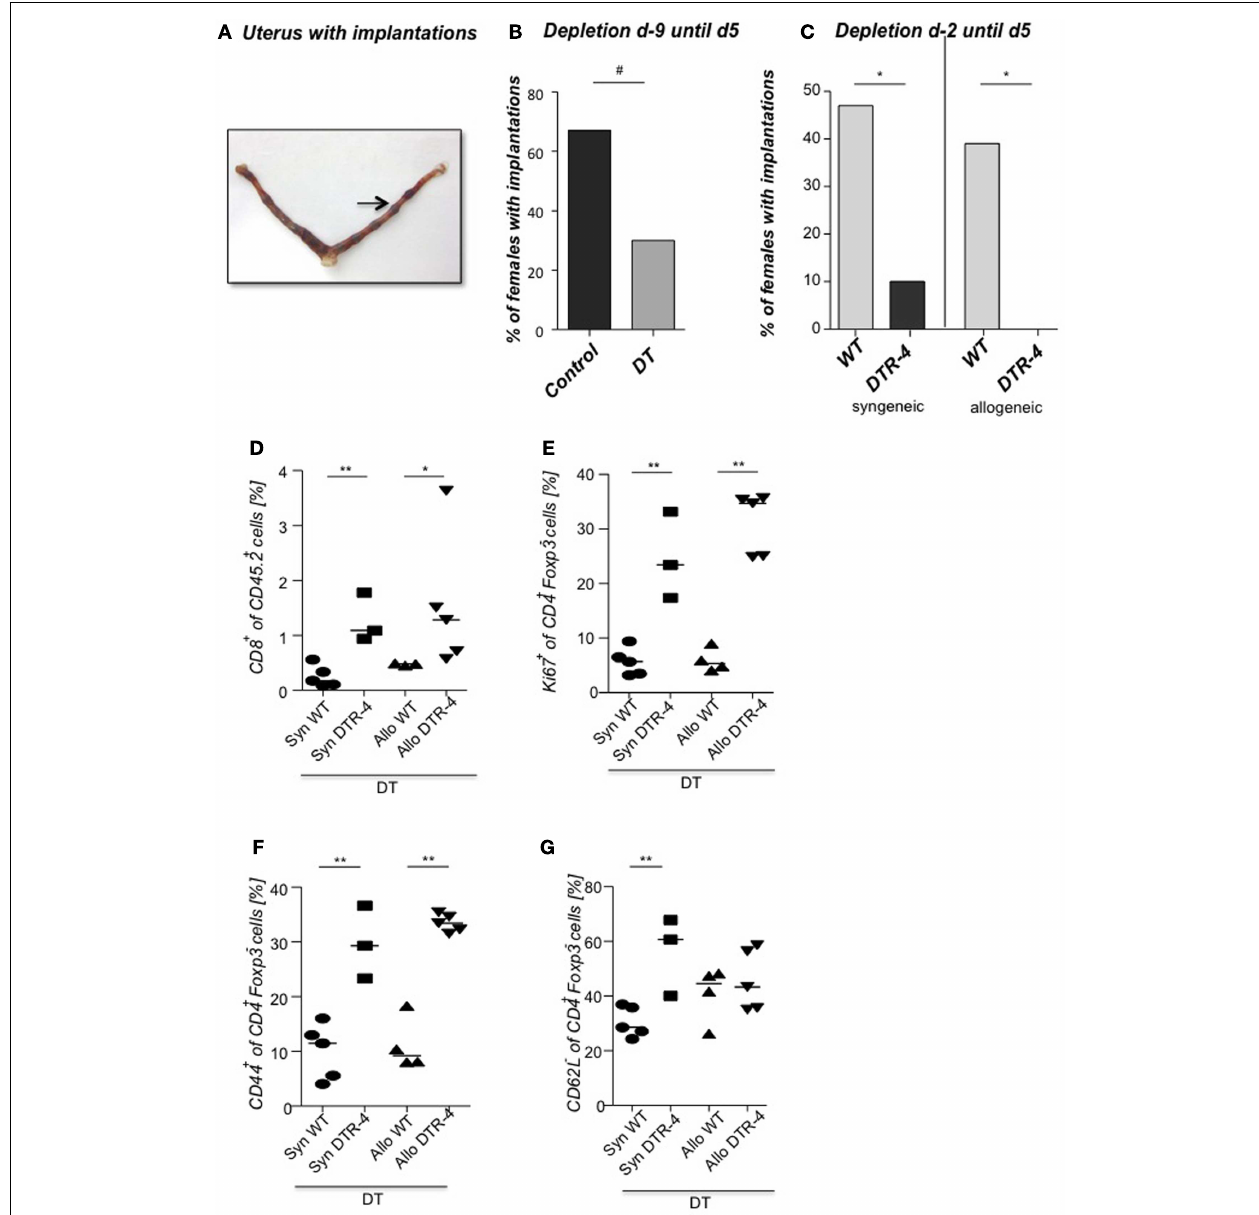
were wt C57/BL6 females treated with DT. Implantation numbers were measured at day 5 [ (C) , n = 15–21]. For (B,C) , data are expressed as medians of % of implanted females and analyzed by Fisher’s exact test (# P < 0.1, * P < 0.05). Not all plugged animals became pregnant. In samples from animals shown in Figure 3B, the percentage of CD8 + cells was analyzed in the uterus by flow cytometry (D) , and the percentage of KI67 + , CD44 + , and CD62L + (E–G) determined in uterine draining lymph nodes ( n = 5/group). Data are expressed as medians and were analyzed by Mann–Whitney- U test (* P < 0.05; ** P <